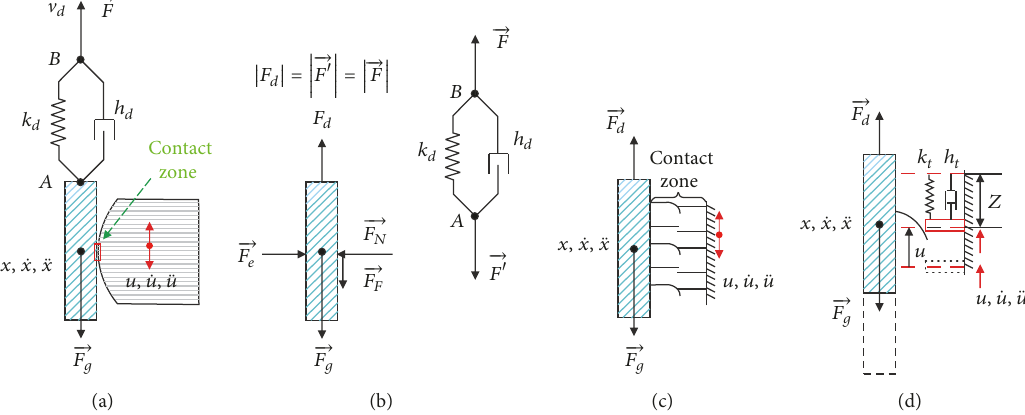
Figure 6: Simplified model for the analysis of friction in the presence of axial sliding and vibration. (a) Interaction model of the sliding- vibration system; (b) distribution of forces acting on the sliding body; (c) distribution of asperities in the contact zone; (d) elastic deformation of the contact zone in the presence of axial